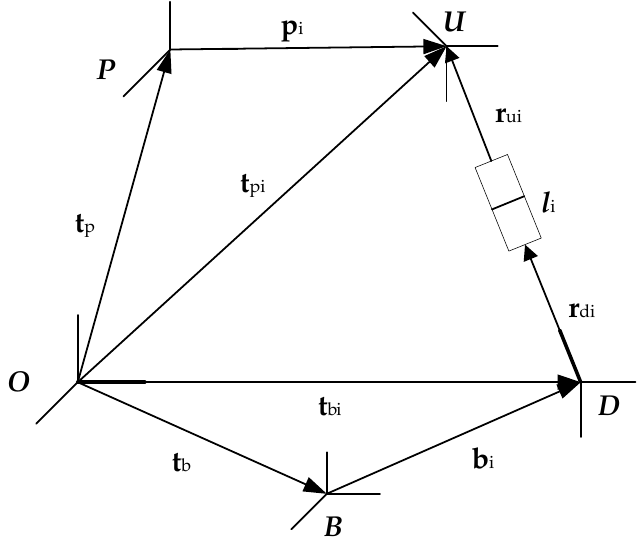
Figure 4. The inertial frame and the local frames.